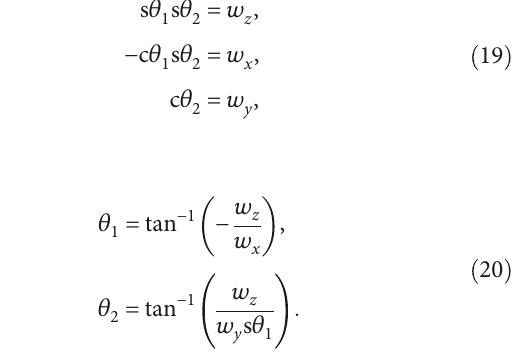
Figure 8 is the result of the input joint variables θ 1 and θ 2 .